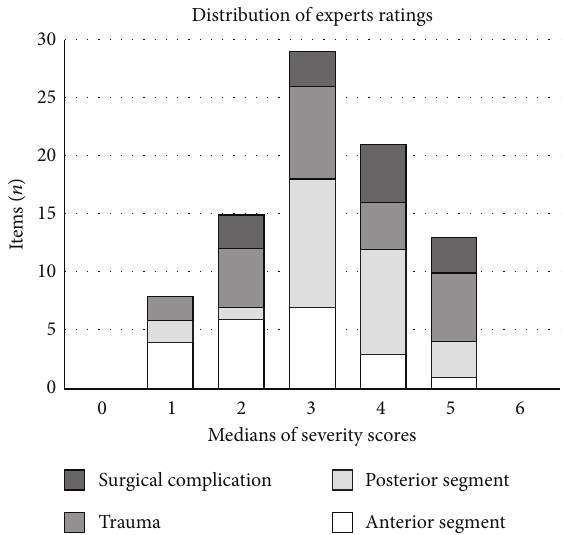
Figure 2: Distribution of the severity score medians weighted from 0 to 6, obtained by consensus among the four proposed categories of items (anterior segment, posterior segment, traumatisms, and complication of ocular surgical